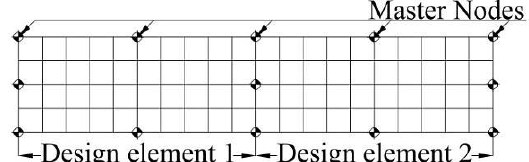
Figure 1. Representation of probable design elements and location of master